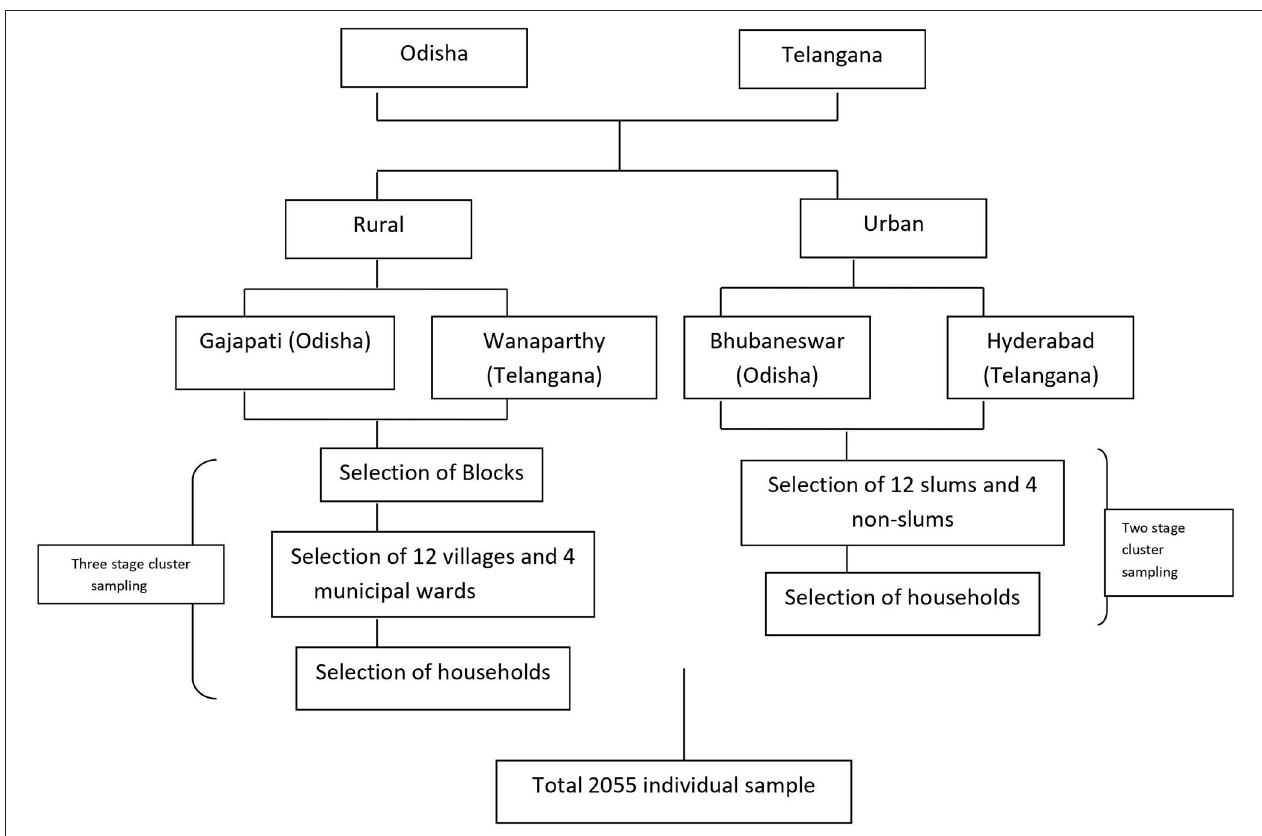
FIGURE 2 | Multistage cluster sampling